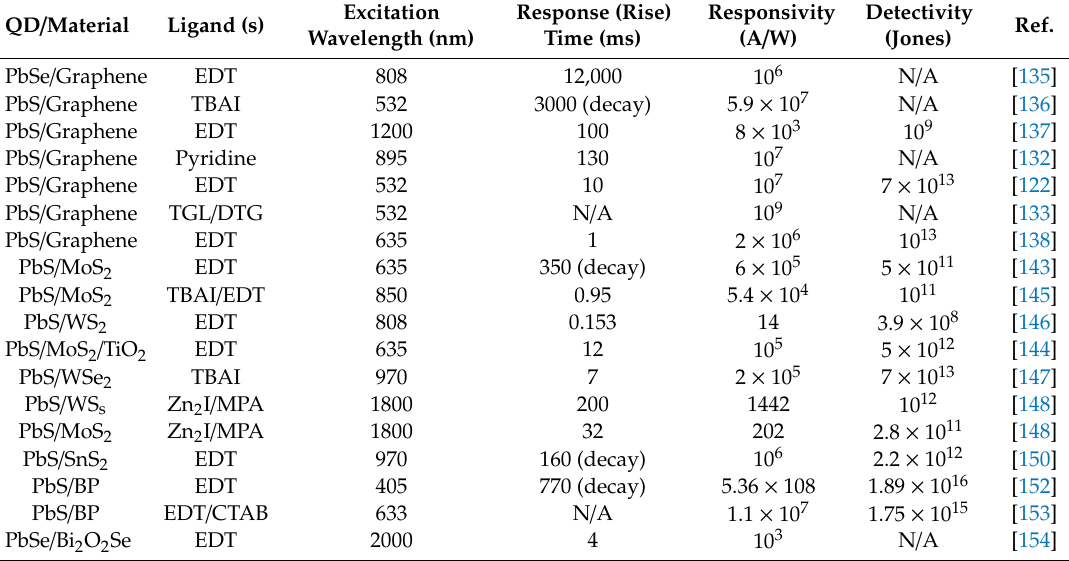
Table 1. Hybrid PbE QD-layered 2D photodetectors and their corresponding figures of merit. All detectors presented in this table are phototransistors, with one detector that from [138] utilizing a hybrid phototransistor / photodiode geometry. EDT = ethanedithiol, TBAI = tetrabutylammonium iodide, TGL = thioglycerol, DTG = 2, 3-dimercapto-1-propanol, MPA = mercaptopropionic acid, and CTAB = cetyltrimethylammonium